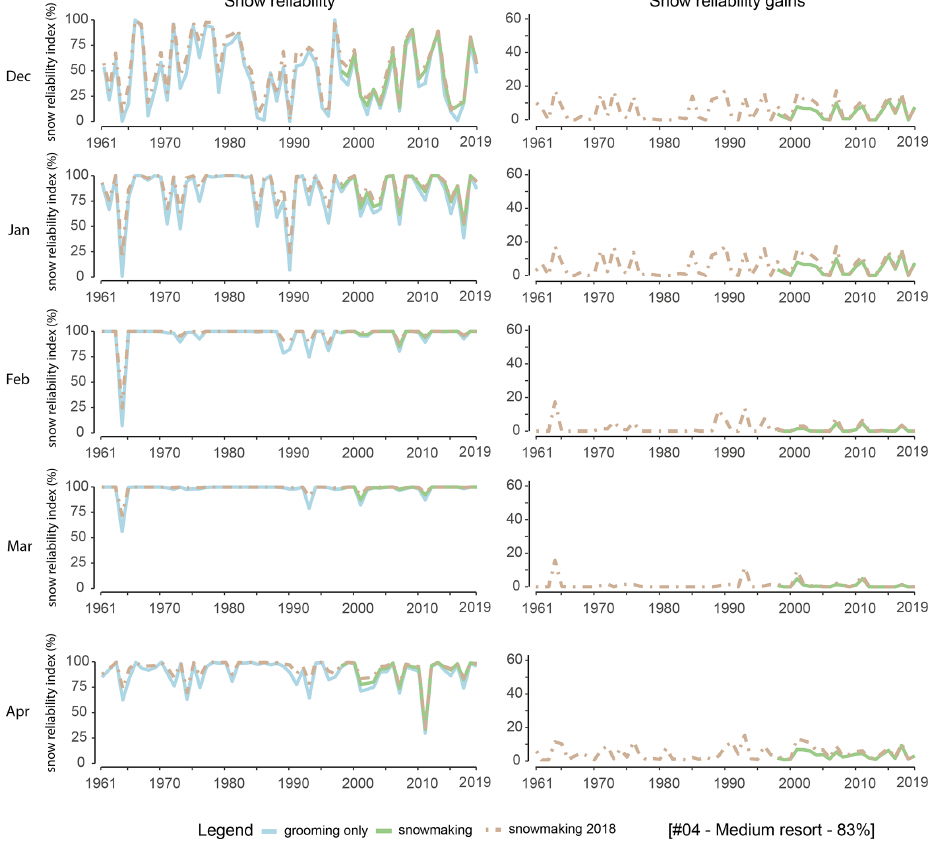
https://doi.org/10.5194/tc-16-863-2022 The Cryosphere, 16, 863–881,